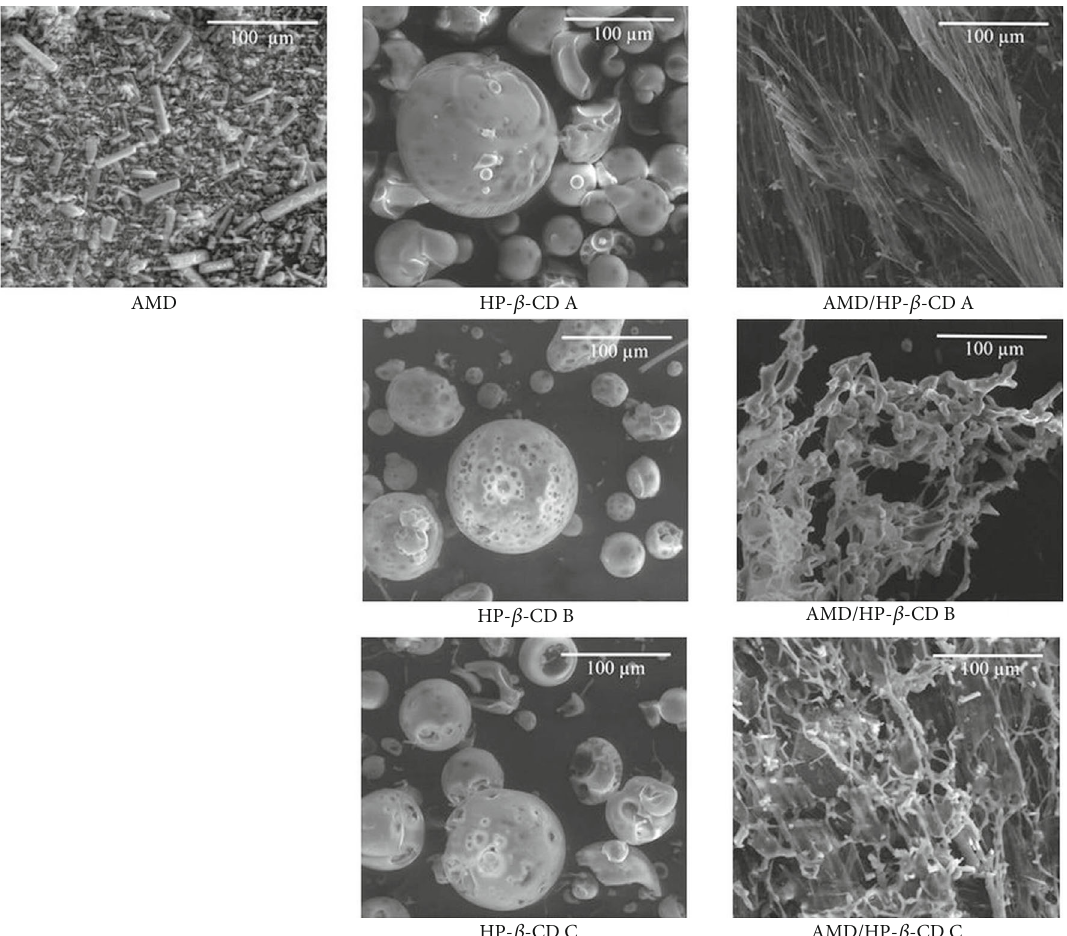
Figure 2: SEM images of AMD, HP- β -CD, and corresponding inclusion complexes; magni fi cation 100 μ m indicated on fi